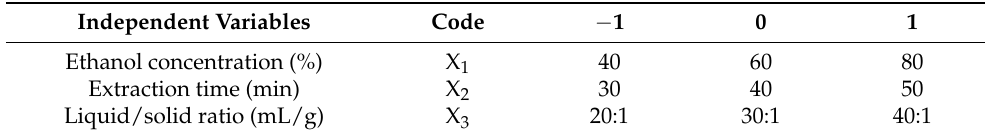
Table 1. Levels of factors for the UAE.